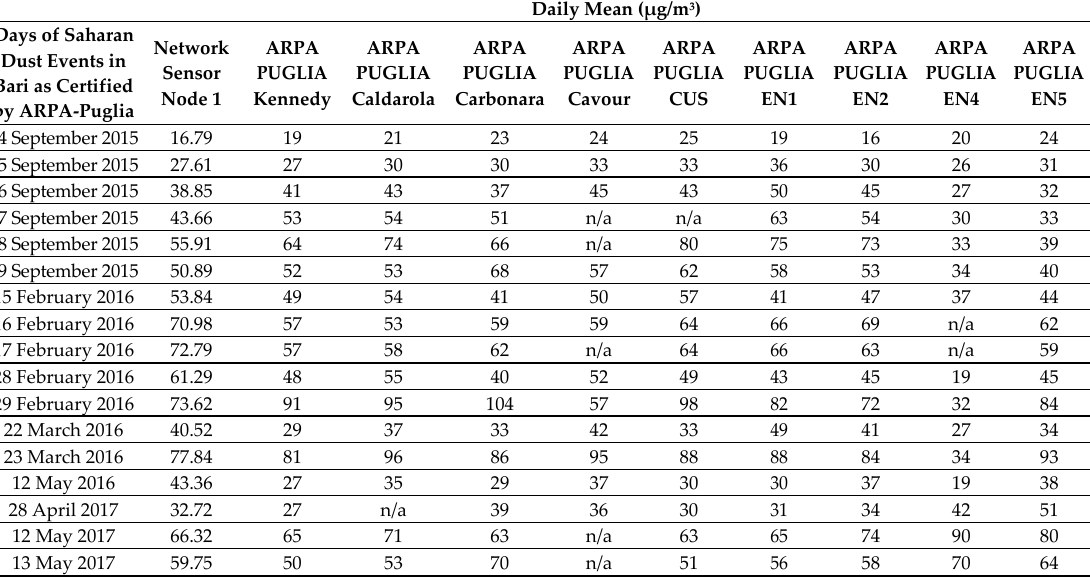
Table 1. PM 10 daily mean ( μ g/m 3 ) of a selected sensor node (Node 1, ENEL) versus the Air Quality Monitoring Stations (9 AQMS), managed by ARPA-Puglia, during the Saharan dust events at Bari in the period